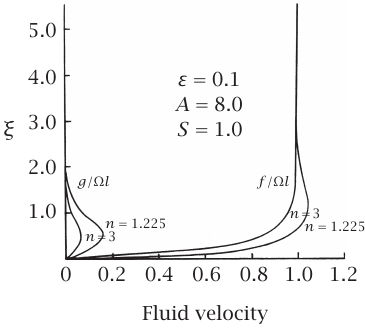
Figure 3.6 . Variations of f/ Ω l and g/ Ω l with frequency n of the fluctuation in suction